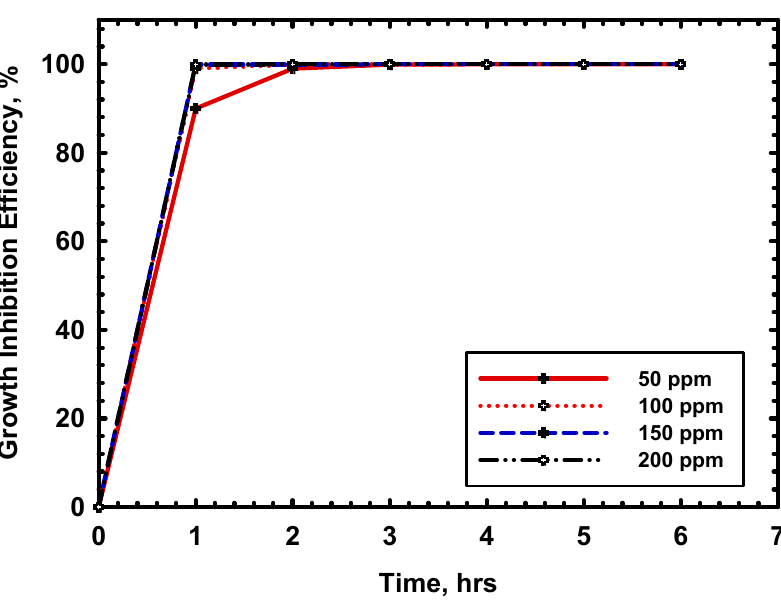
Figure 5. The inhibition efficiency of the bacterial growth in presence of different concentrations of